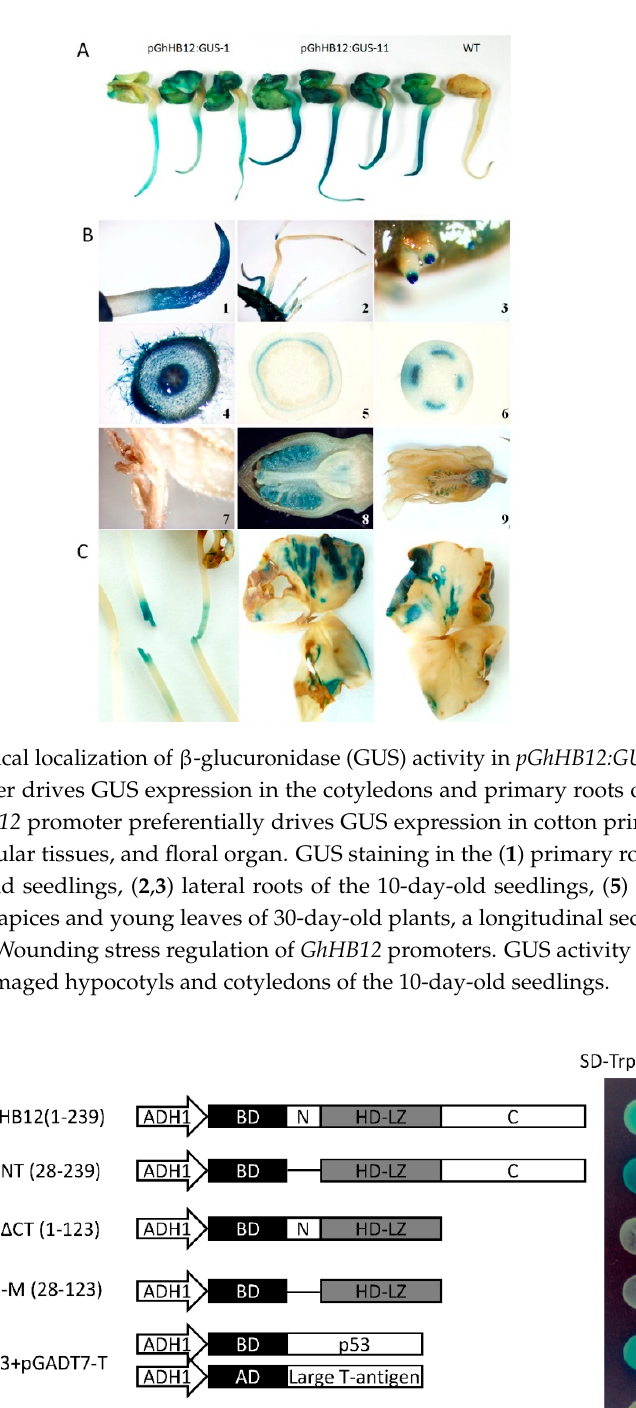
Figure 3. Transactivation analysis of the full-length GhHB12 protein and truncated GhHB12 proteins in yeast. The transformants were streaked on SD-Trp plus x- α -gal medium. pGBKT7-53+pGADT7-T was used as the positive controls, pGBKT7-Lam was used as the negative controls. BD: DNA binding domain of GAL4; AD: Activating domain of GAL4; ADH1: ADH1 promoter; N: N-terminal region; C: C-terminal region; HD-LZ: the HD and Zip domain; BD-GhHB12(1-239): Full-length GhHB12 (1-239 aa) fused to GAL4-BD; BD-GhHB12- ∆ NT(28-239): GhHB12 without N-terminal region fused to GAL4-BD; BD-GhHB12- ∆ CT(1-123): GhHB12 without C-terminal region fused to GAL4-BD; BD-GhHB12-M(28-123): GhHB12 without N-terminal and C-terminal region fused to